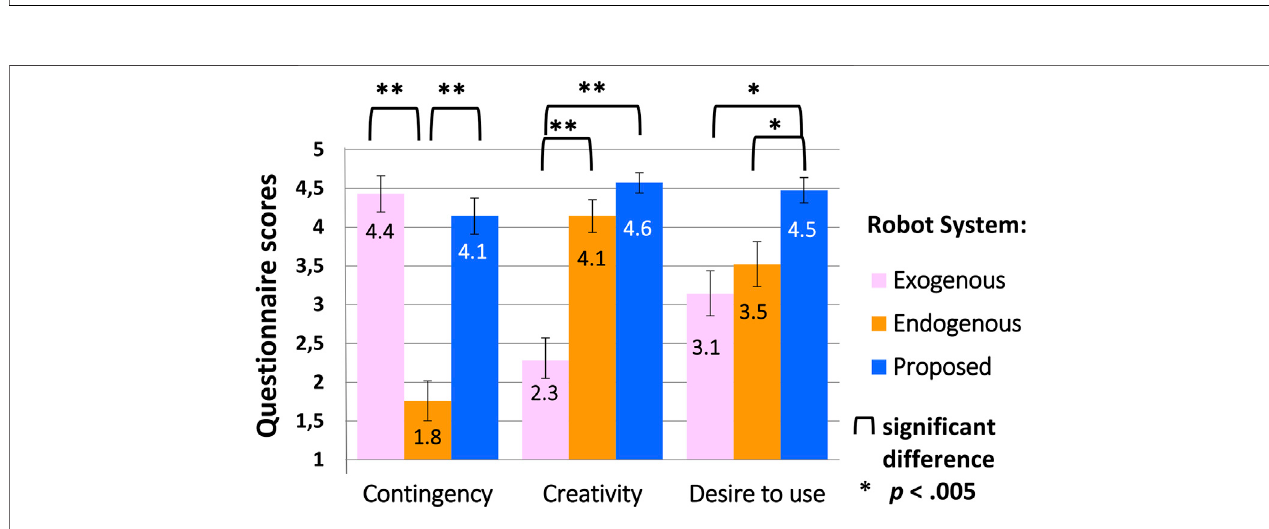
FIGURE 4 | Questionnaire results for robot art-making